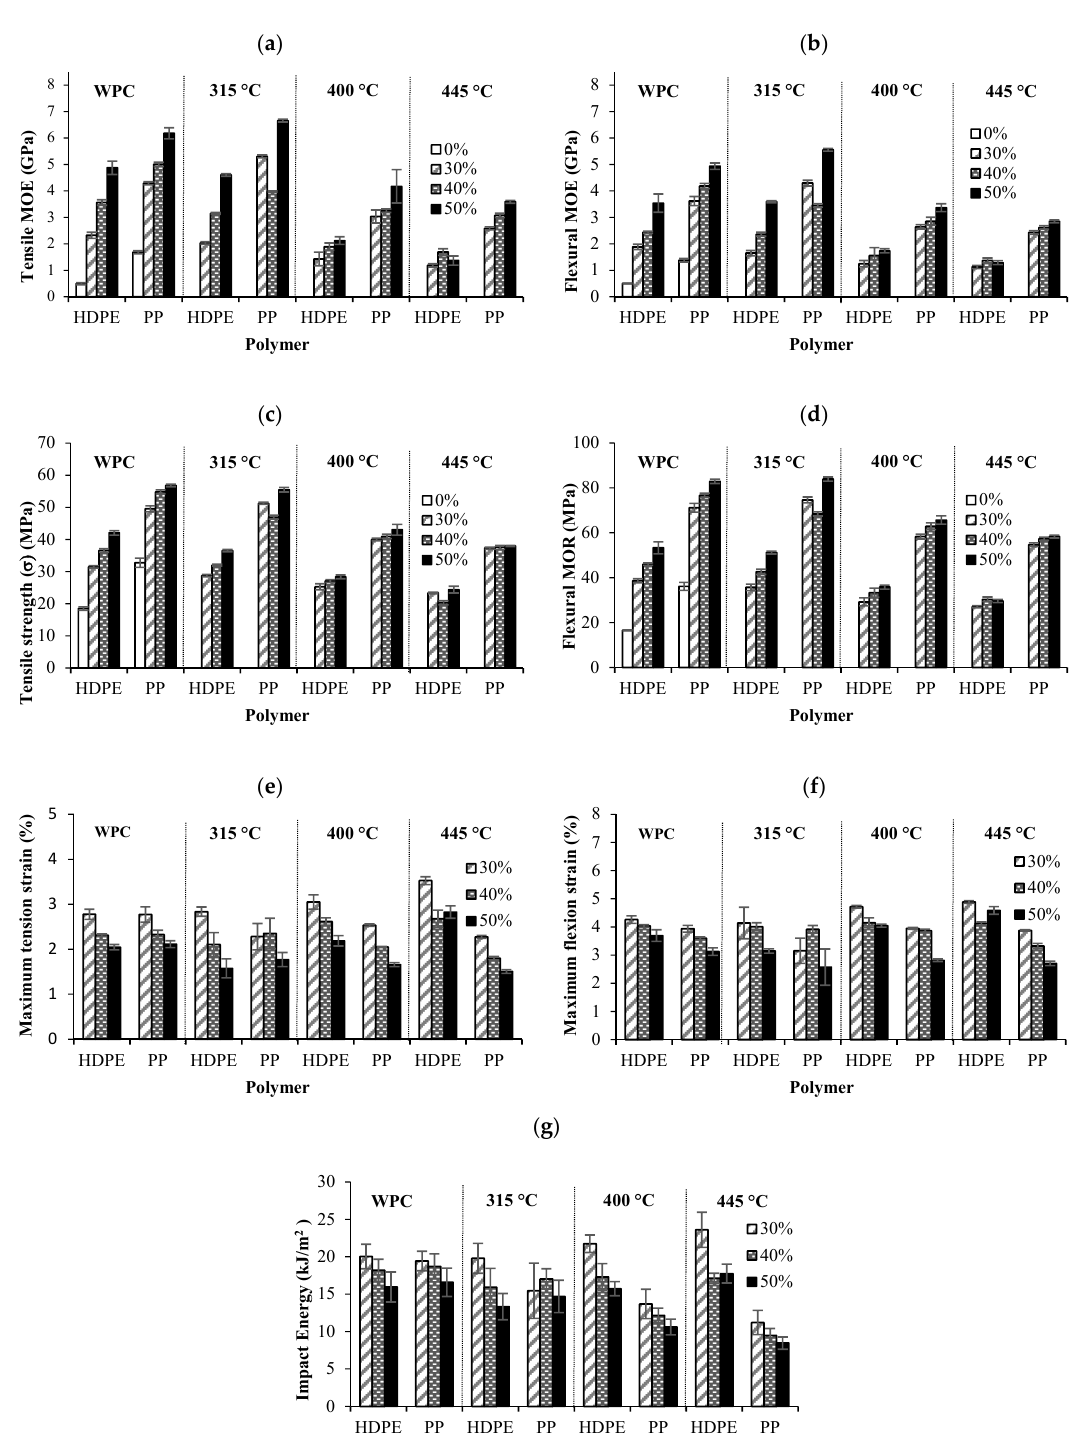
Figure 3. Variation of: ( a ) tensile modulus of elasticity (MOE), ( b ) flexural modulus of elasticity (MOE), ( c ) tensile strength, ( d ) flexural modulus of rupture (MOR), ( e ) maximum tensile strain, ( f ) maximum flexural strain and ( g ) impact energy of biocomposites made with wood and biochar.